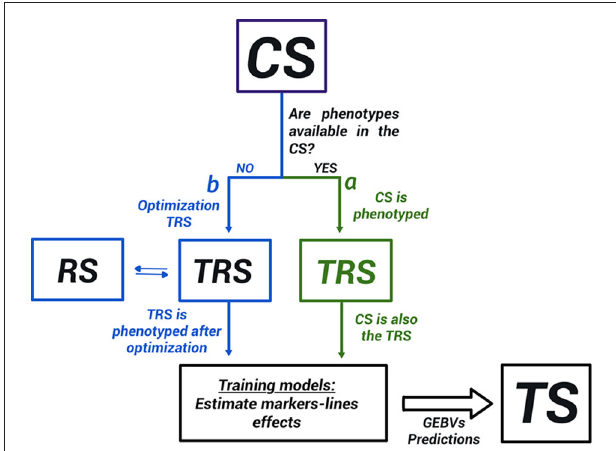
FIGURE 1 | Populations in genomic selection (GS). CS, calibration set, TRS, training set, RS, remaining set, and TS is the test set. When CS has all the phenotypic and genotypic information, CS and TRS are the same populations. Otherwise, we could have up to four different populations in the GS scheme. There are two different types of TRS selection problems: in one of these (a), the CS is already phenotyped and genotyped, and a subset of the CS is used as a TRS in the modeling stage. In the other (b), the CS is only genotyped and a TRS is constructed by phenotyping a subset of the